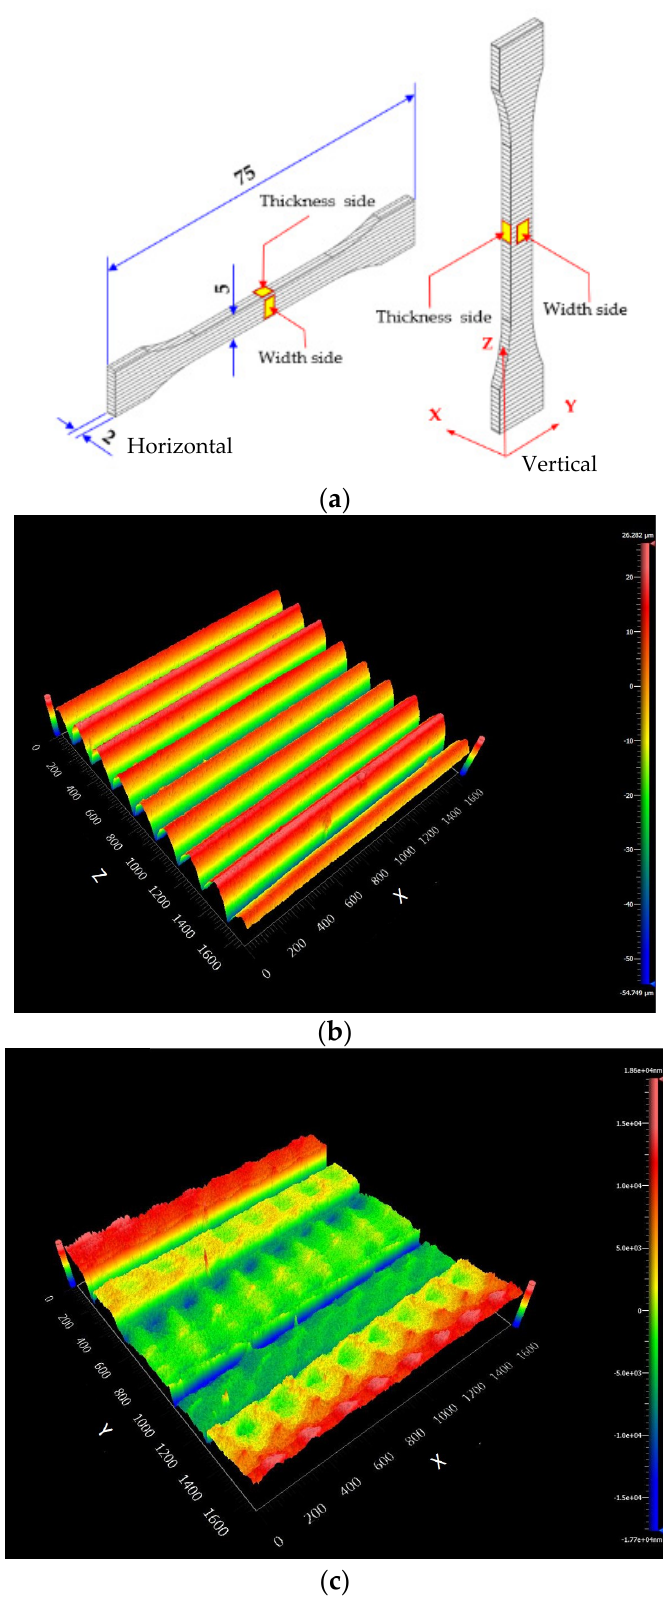
Figure 9. ( a ) Sample observation direction of surface roughness and examples of 3D surface roughness profiles: ( b ) 3D surface roughness profile from width side; ( c ) 3D surface roughness profile from thickness